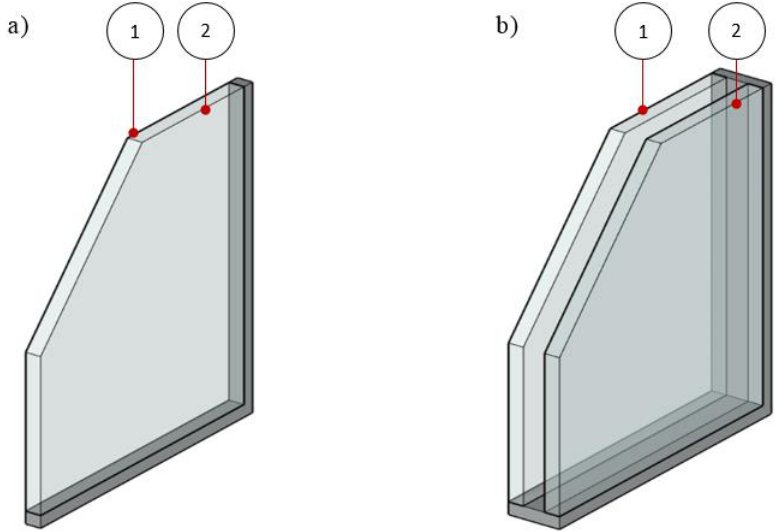
Figure 1. The positions of SSAF for existing buildings’ glazing systems: ( a ) single glazing system ( ① the inner surface and ② the outer surface); ( b ) double glazing system ( ① the inner surface and ② the outer surface).